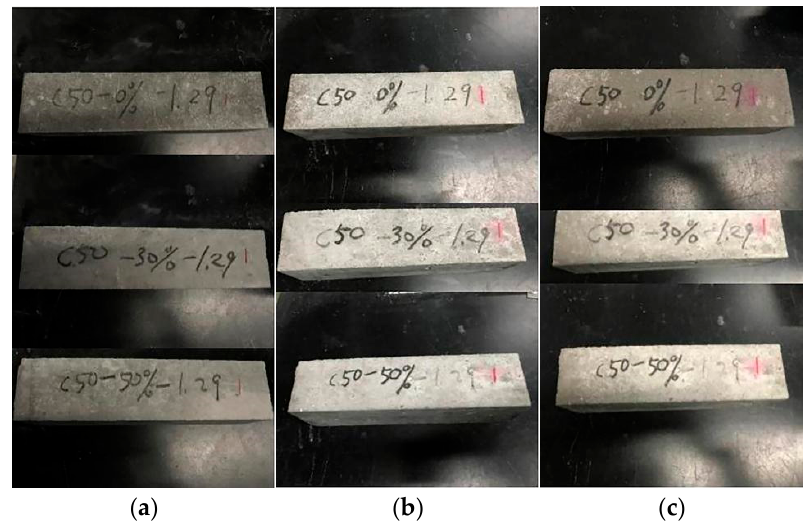
Figure 5. Damage shapes of different freeze–thaw cycles of C45 concretes. ( a ) 0 cycle, ( b ) 250 cycles, ( c ) 300 cycles.